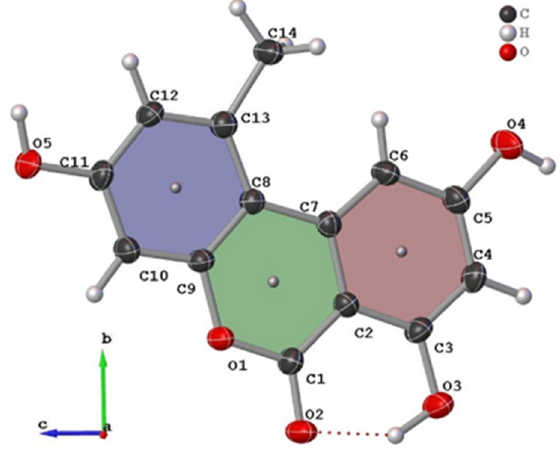
Figure 1. Crystal structure and labeling scheme of alternariol Form II with thermal ellipsoids at 50% probability. Plane 1 (red), Plane 2 (green) and Plane 3 (blue) are also shown.